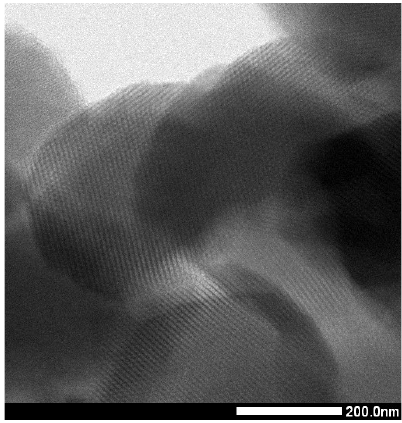
Figure 5. HRTEM micrograph of SBA-15.